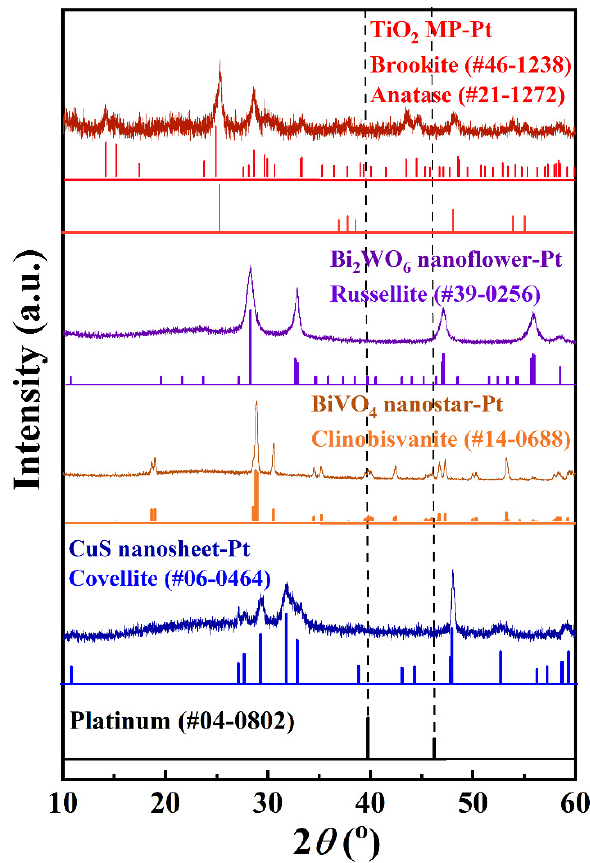
Figure 2. XRD patterns of Pt-deposited TiO 2 MP nanofiber, Pt-deposited Bi 2 WO 6 nanoflower, Pt-deposited BiVO 4 nanostar, and Pt-deposited CuS nanosheet.